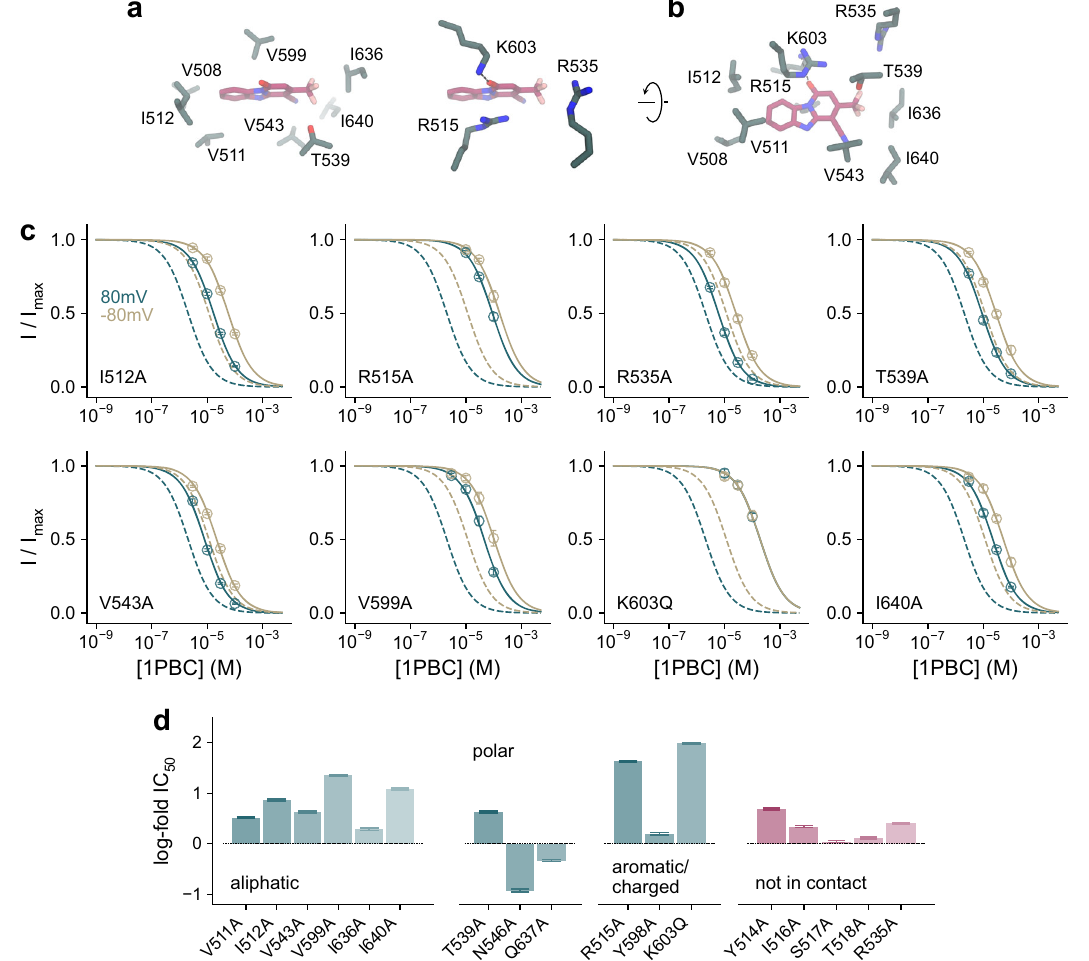
Fig. 5 Interacting residues. a, b Close-up of selected residues surrounding the bound 1PBC. c Concentration-response relations of 1PBC of selected mutants at a saturating Ca 2 + concentration at − 80 and 80 mV. Data are averages of the indicated number of biological replicates shown in Supplementary Table 1, errors are SEM. Solid lines are fi ts to the Hill equation. Dashed lines are the relations of WT. d Log-fold changes in IC 50 of mutants at 80 mV. Mutants of residues in contact with the blocker are shown in green. Bars indicate IC 50 values obtained via a fi t of the averaged data shown in Supplementary Fig. 7 to the Hill equation, errors are 95% CI. The number of biological replicates is shown in Supplementary Table 1.